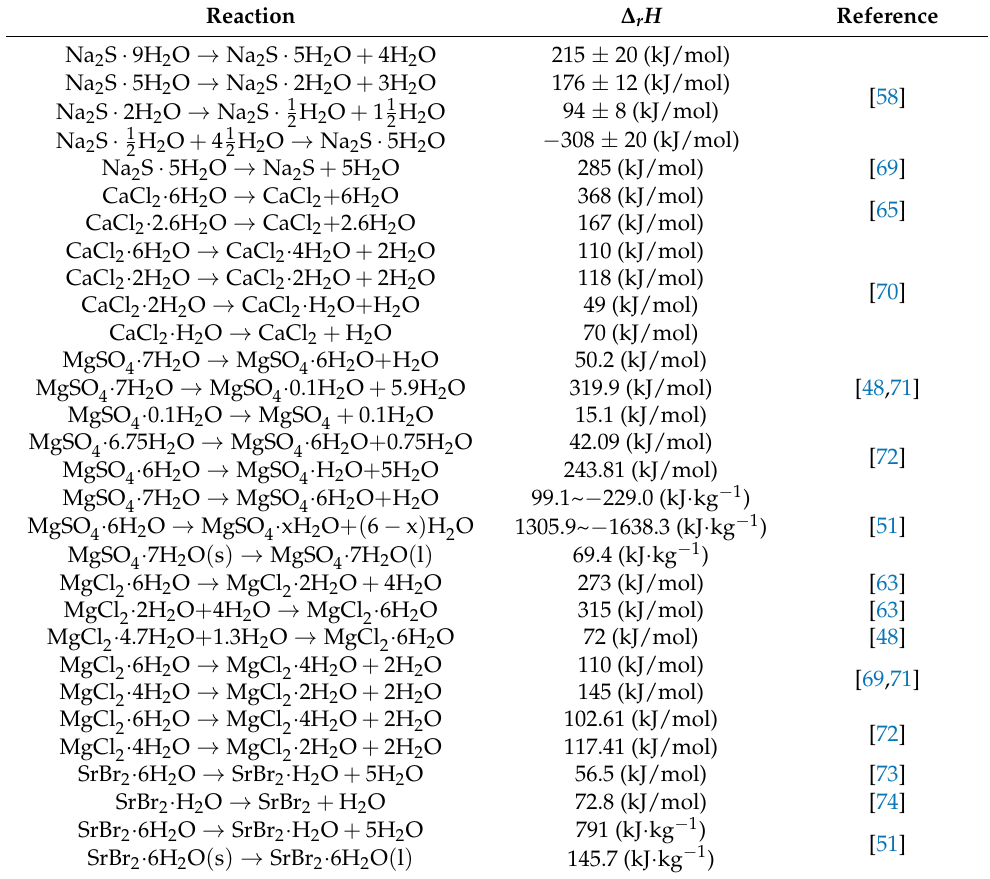
Table 2. Reaction enthalpy of each step for the main salt